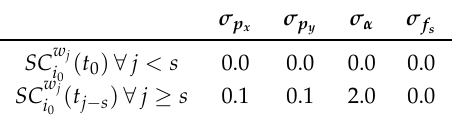
Table 1. Sigma values of the starting conditions (SC) for the first iteration of window w j